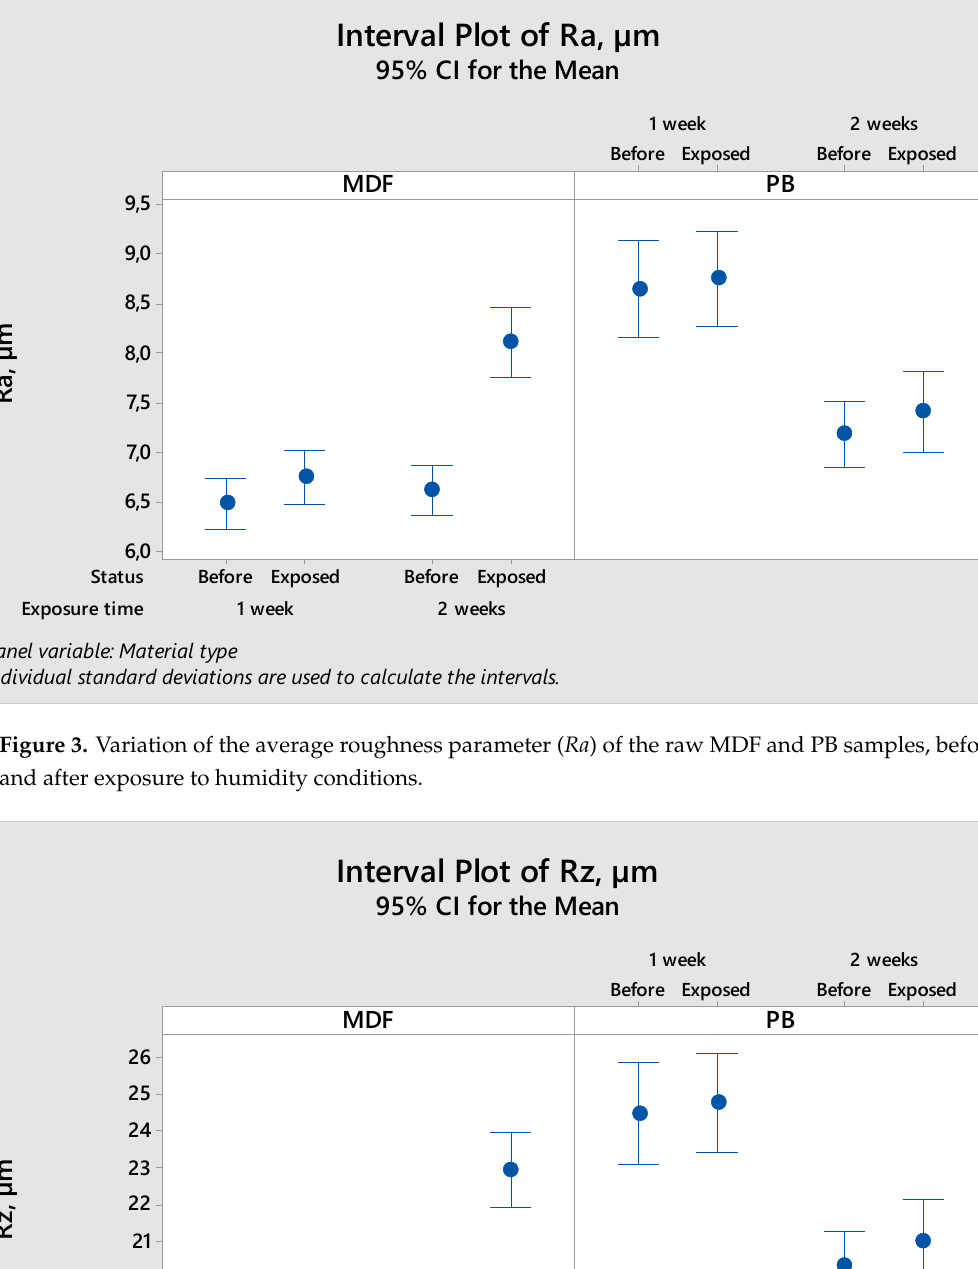
timeStatus Exposure 2 weeks1 week Panel variable: Material type Individual standard deviations are used to calculate the intervals. Figure 4. Variation of the mean peak-to-valley height parameter ( Rz ) of the raw MDF and PB samples, before and after exposure to humidity conditions.